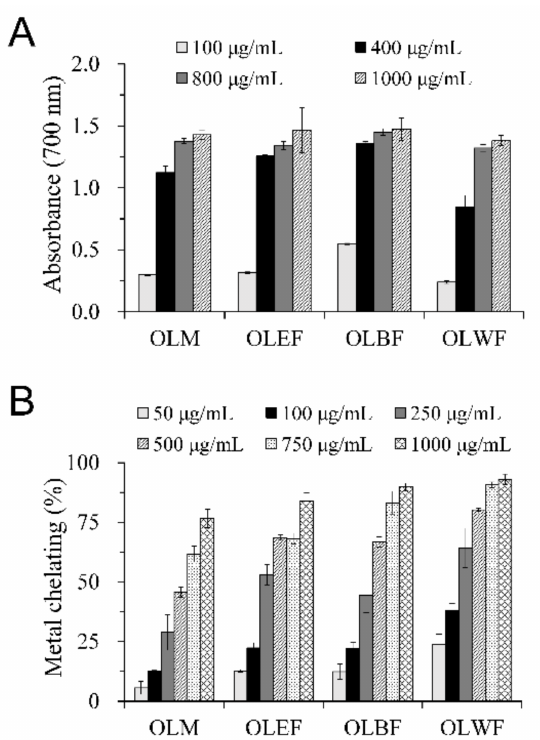
Figure 1. Antioxidant properties of OLM and its different soluble fractions were determined using the ferrous reducing antioxidant capacity assay ( A ) and ferrous-ion chelation assay ( B ). Test samples were the methanolic extract of O. laciniata (OLM) and its different soluble partition fractions, including ethyl acetate (OLEF), n -butanol (OLBF), and water (OLWF). ( A ) The reducing power was determined using the Fe 3+ –Fe 2+ system with higher absorbance at 700 nm, indicating a stronger reducing power. ( B ) The Fe 2+ chelating activity (%) was calculated based on the absorbance of reaction mixtures measured at 562 nm. Values are the mean ± SD of independent triplicate